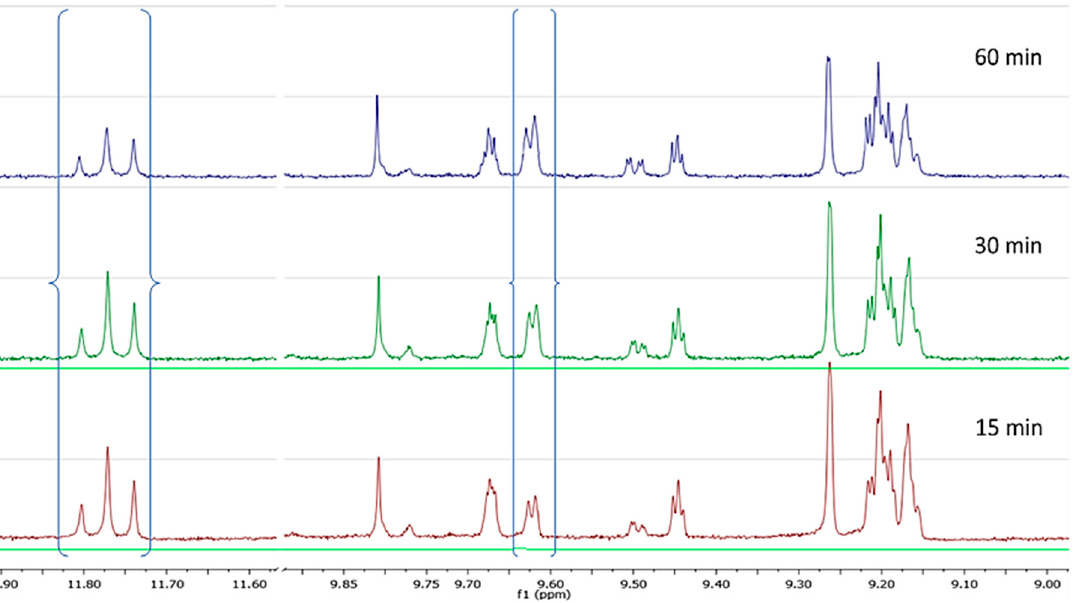
Figure 7. NMR profile of cv Olympia at 28 °C, at three malaxation times, showing the characteristic peaks of the analyzed phenolic compounds.